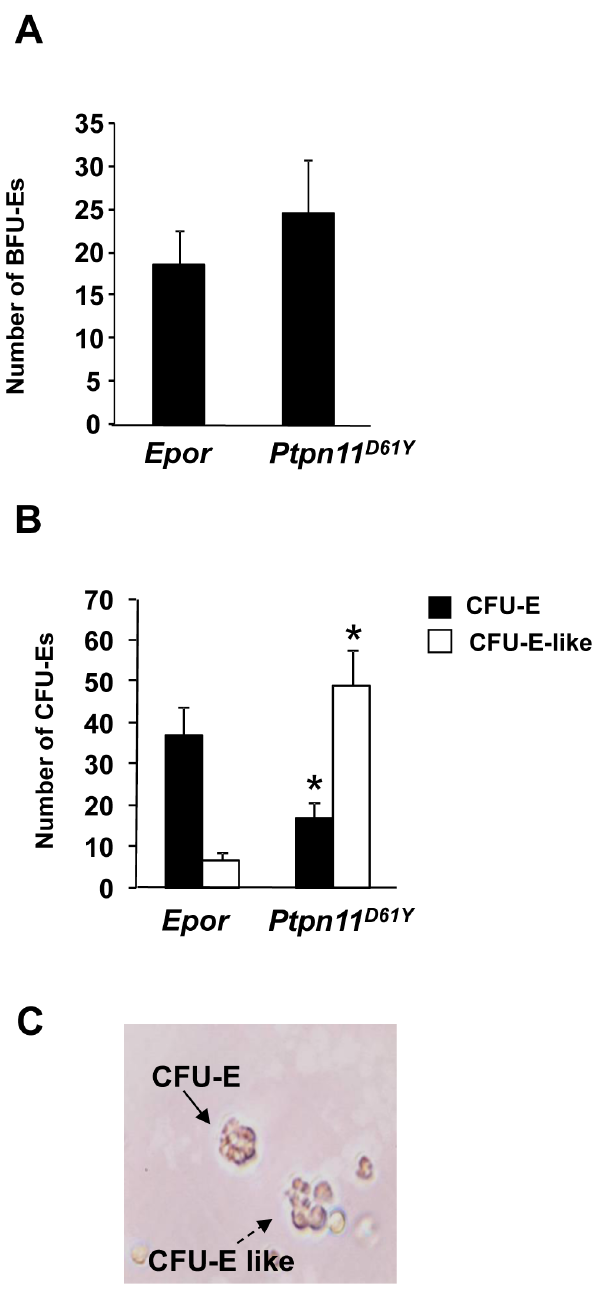
Figure 2. Erythroid differentiation of Ptpn11 D61Y BM cells. (A) BFU-E assays performed using BM from Epor and Ptpn11 D61Y mice. Numbers (mean 6 SD, n=6) of BFU-E per 5 6 10 4 cells plated are shown. (B) CFU-E assays of BM cells from Epor and Ptpn11 D61Y mice. Numbers (mean 6 SD, n=6) of CFU-E and CFU-like colonies per 5 6 10 4 cells plated are shown. * p # 0.05, ANOVA. (C) Representative picture of CFU-E with immature phenotype.